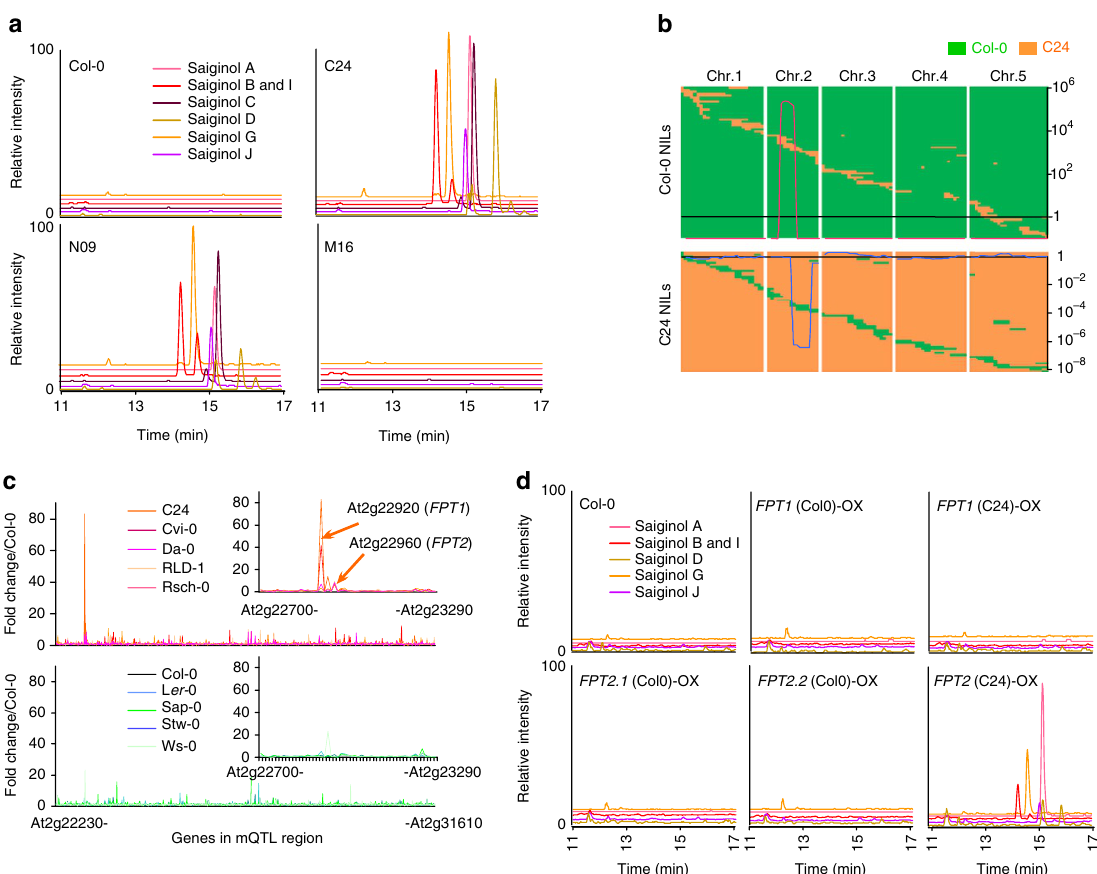
Figure 2 | Functional identification of the FPT genes based on integrative approach. ( a ) LC/MS chromatogram and ( b ) chromosomal mapping of gain-of-function and loss-of-function NILs obtained from metabolic quantitative trait locus (mQTL) analysis of reciprocal crosses between Col-0 and C24. N and M lines are Col-0 and C24 background introgression lines, respectively. Green and orange boxes indicate Col-0 and C24 DNA segments, respectively. Metabolic QTL was presented by log 2 -transformed relative amount of saiginol A. ( c ) Microarray analysis of gene expression of the genes encoded in the genomic region of chromosome 2 encoding the mQTL in five producing accessions (C24, Cvi, Da, Rsch and RLD) and five non-producing accessions (Col-0, L er -0, Ws, Sap and Stw). Intensity indicates fold change estimated by average of expression level in Col-0. ( d ) LC/MS chromatogram showing in vivo functional characterization of FPT1 and 2 by metabolite profiling of 35S -driven overexpressing transgenic plants. All transgenic lines are Col-0 background. FPT1 (Col-0), FPT1 (C24), FPT2.1 (Col-0), FPT2.2 (Col-0) and FPT2 (C24) indicate FPT1 cloned from Col-0 and C24, FPT2 cloned from Col-0 ( FPT2.1 is shortest transcript and FPT2.2 is longest transcript) and C24, respectively. Chromatogram showed ion extracted chromatogram for major saiginol A (945 m/z ), B and I (901 m/z ), C (885 m/z ), D (799 m/z ), G (961 m/z ) and J (815 m/z ),